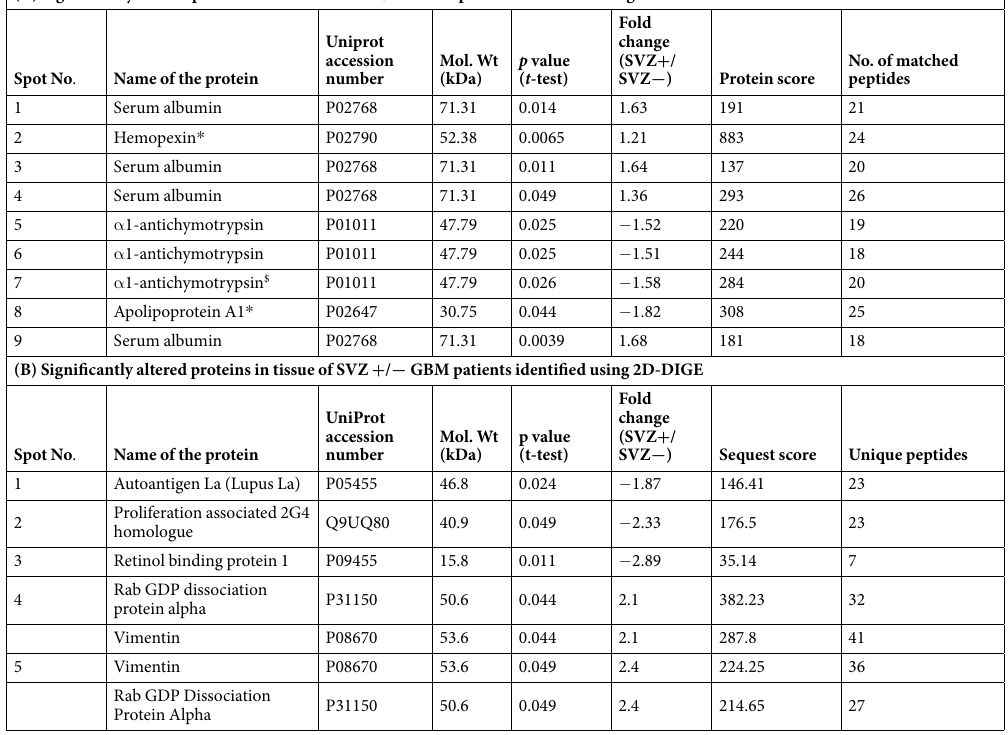
Table 1. List of the differentially expressed and statistically significant protein spots from SVZ + / − GBM patients serum and tissue samples identified using 2D-DIGE method. Note: The proteins with * mark are significant in only 18 out of 24 gels and the proteins with $ mark are significant in 15 out of 24 gels. Remaining proteins are significant in all 24 out of 24